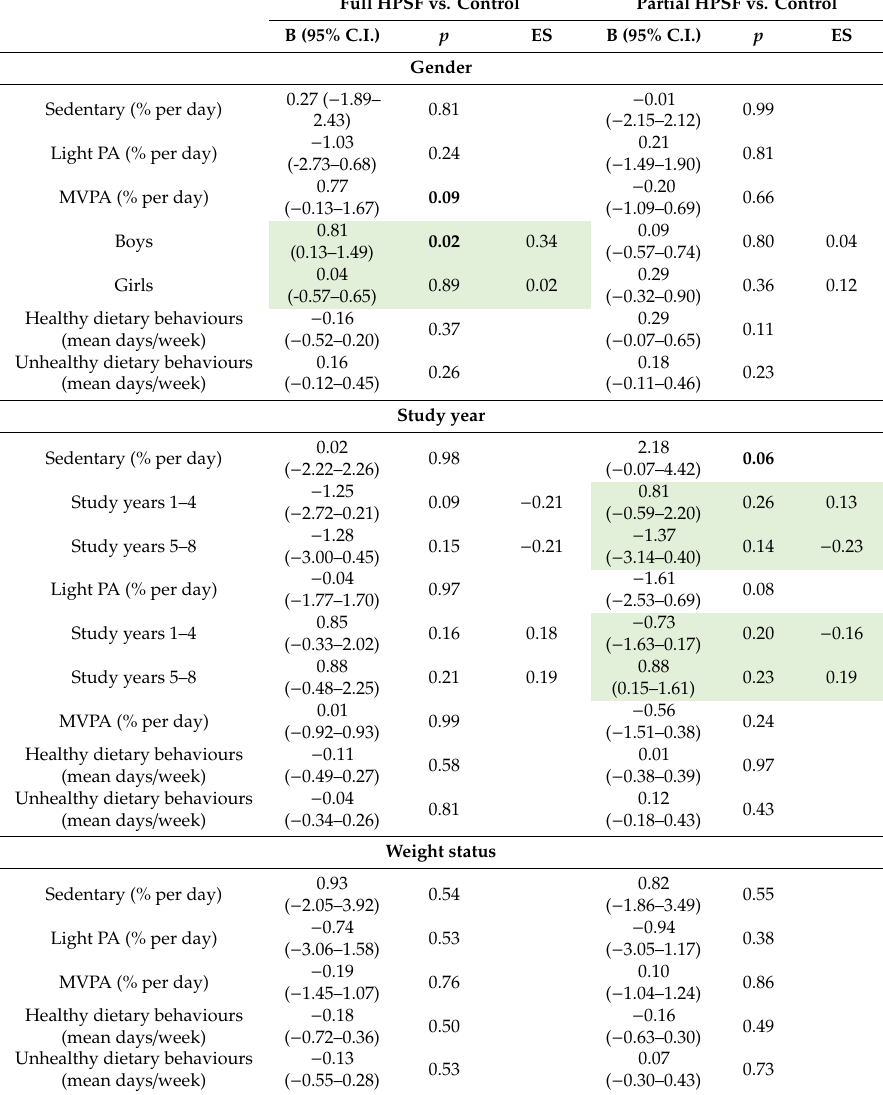
Table 2. E ff ect modifiers of HPSF on overall intervention e ff ects. Full HPSF vs. Control Partial HPSF vs.